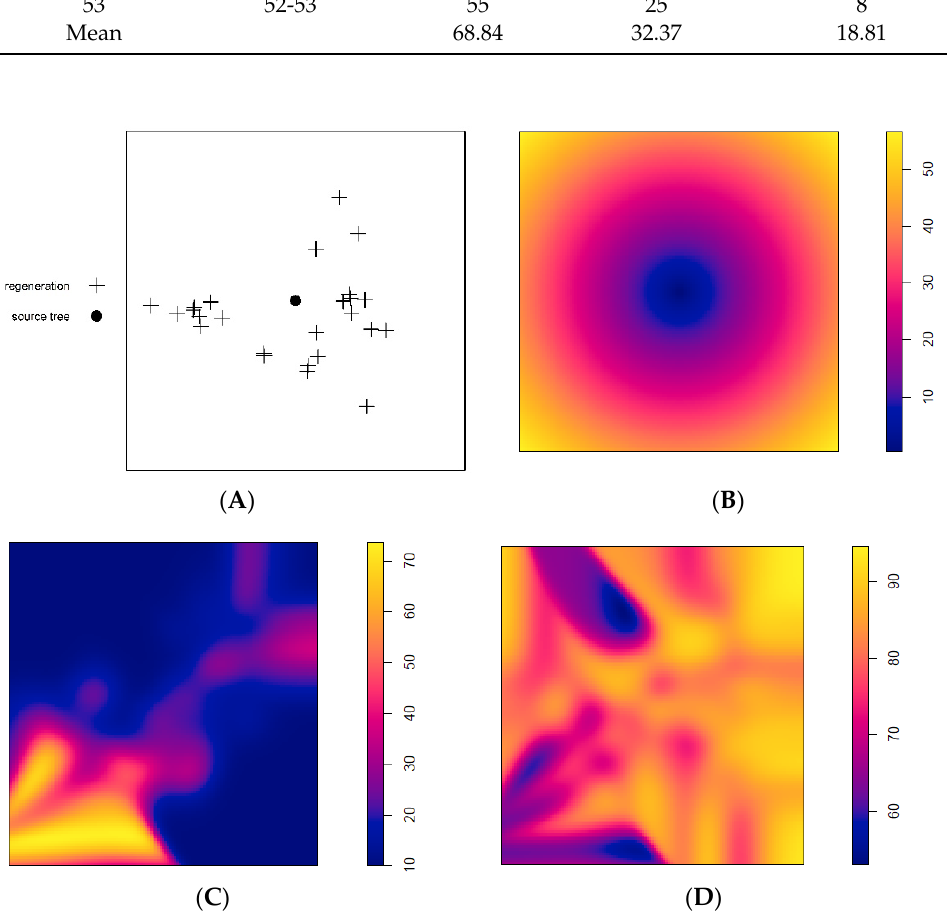
Figure 1. Representative example of the covariate maps created for the forest around a seed tree (example depicts plot 48). ( A ) Tree positions; ( B ) Distance map; ( C ) Smoothed map of ground cover; ( D ) Smoothed map of canopy cover.